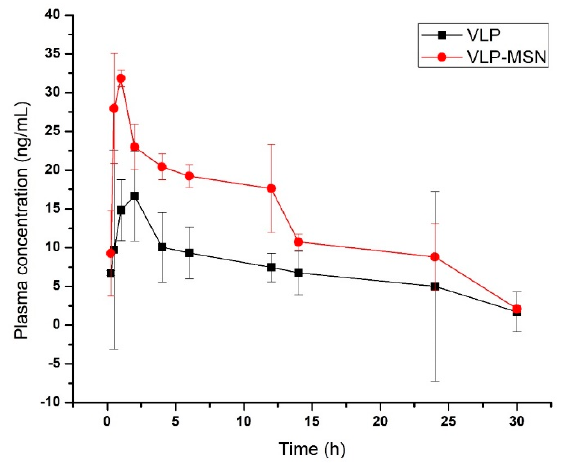
Figure 11. Plasma concentration–time profile of pure VLP and VLP-MSN.